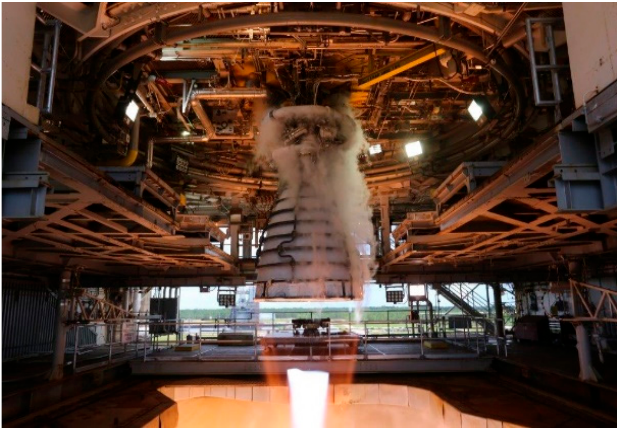
Figure 1. Rocket engine test bench.